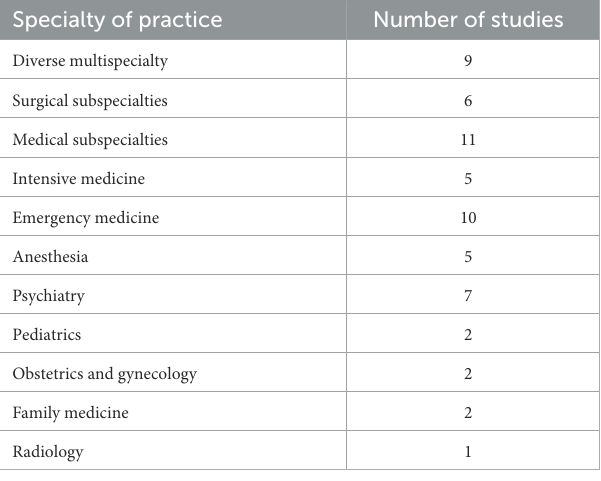
TABLE 1 Descriptive analysis showing the breakdown of the physicians’ medical subspecialties involved in the research from the selected articles ( n = 28).